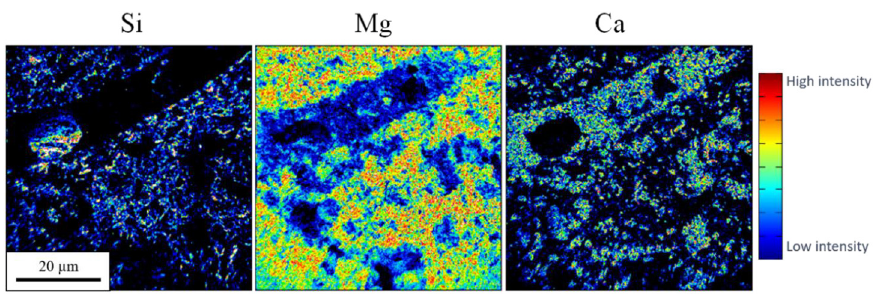
Figure 7. Example of the distribution of silicon (Si), magnesium (Mg), and calcium (Ca) in a chalk sample. The intensity is only relative for each element. Modified from [31].